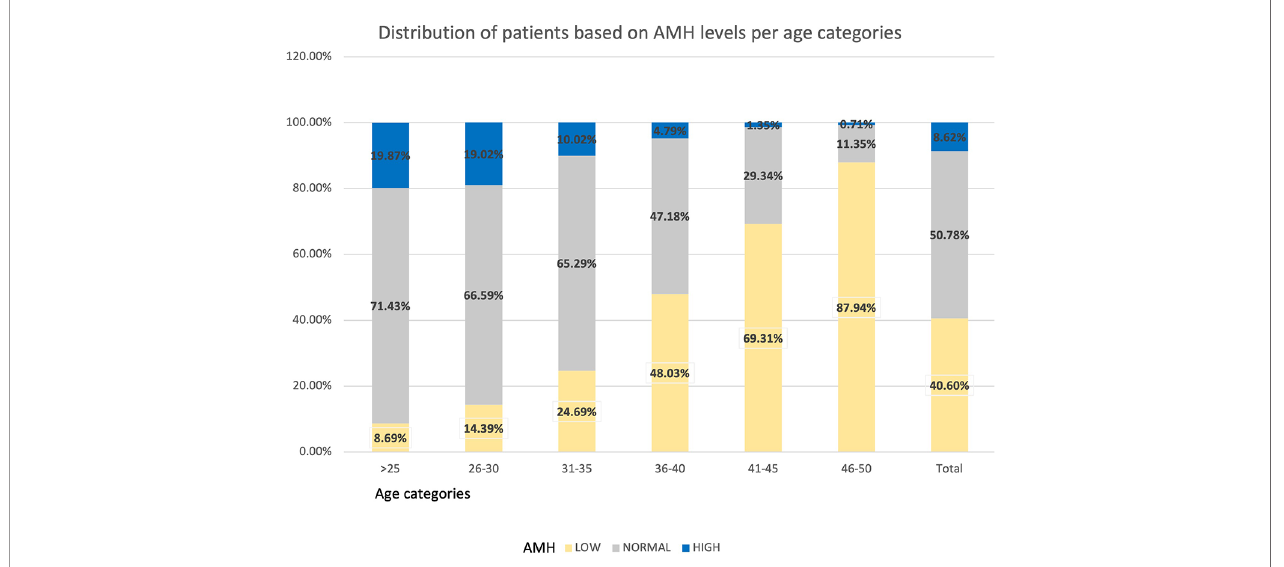
FIGURE 4 | Distribution of patients based on AMH levels per age categories.